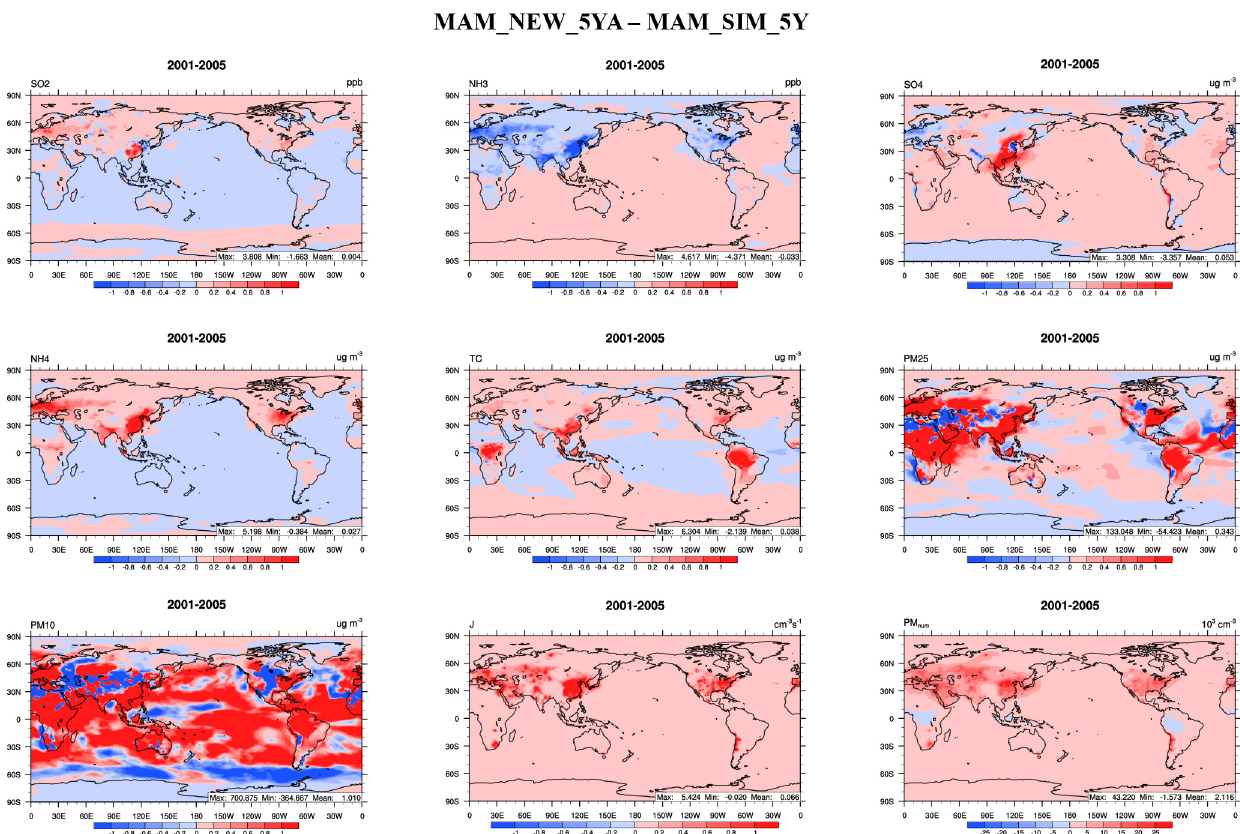
Figure 7. Absolute differences of major aerosol species and their gas precursors, new particle formation rate ( J ), and aerosol number between MAM_NEW_5YA and MAM_SIM_5Y for 2001–2005.